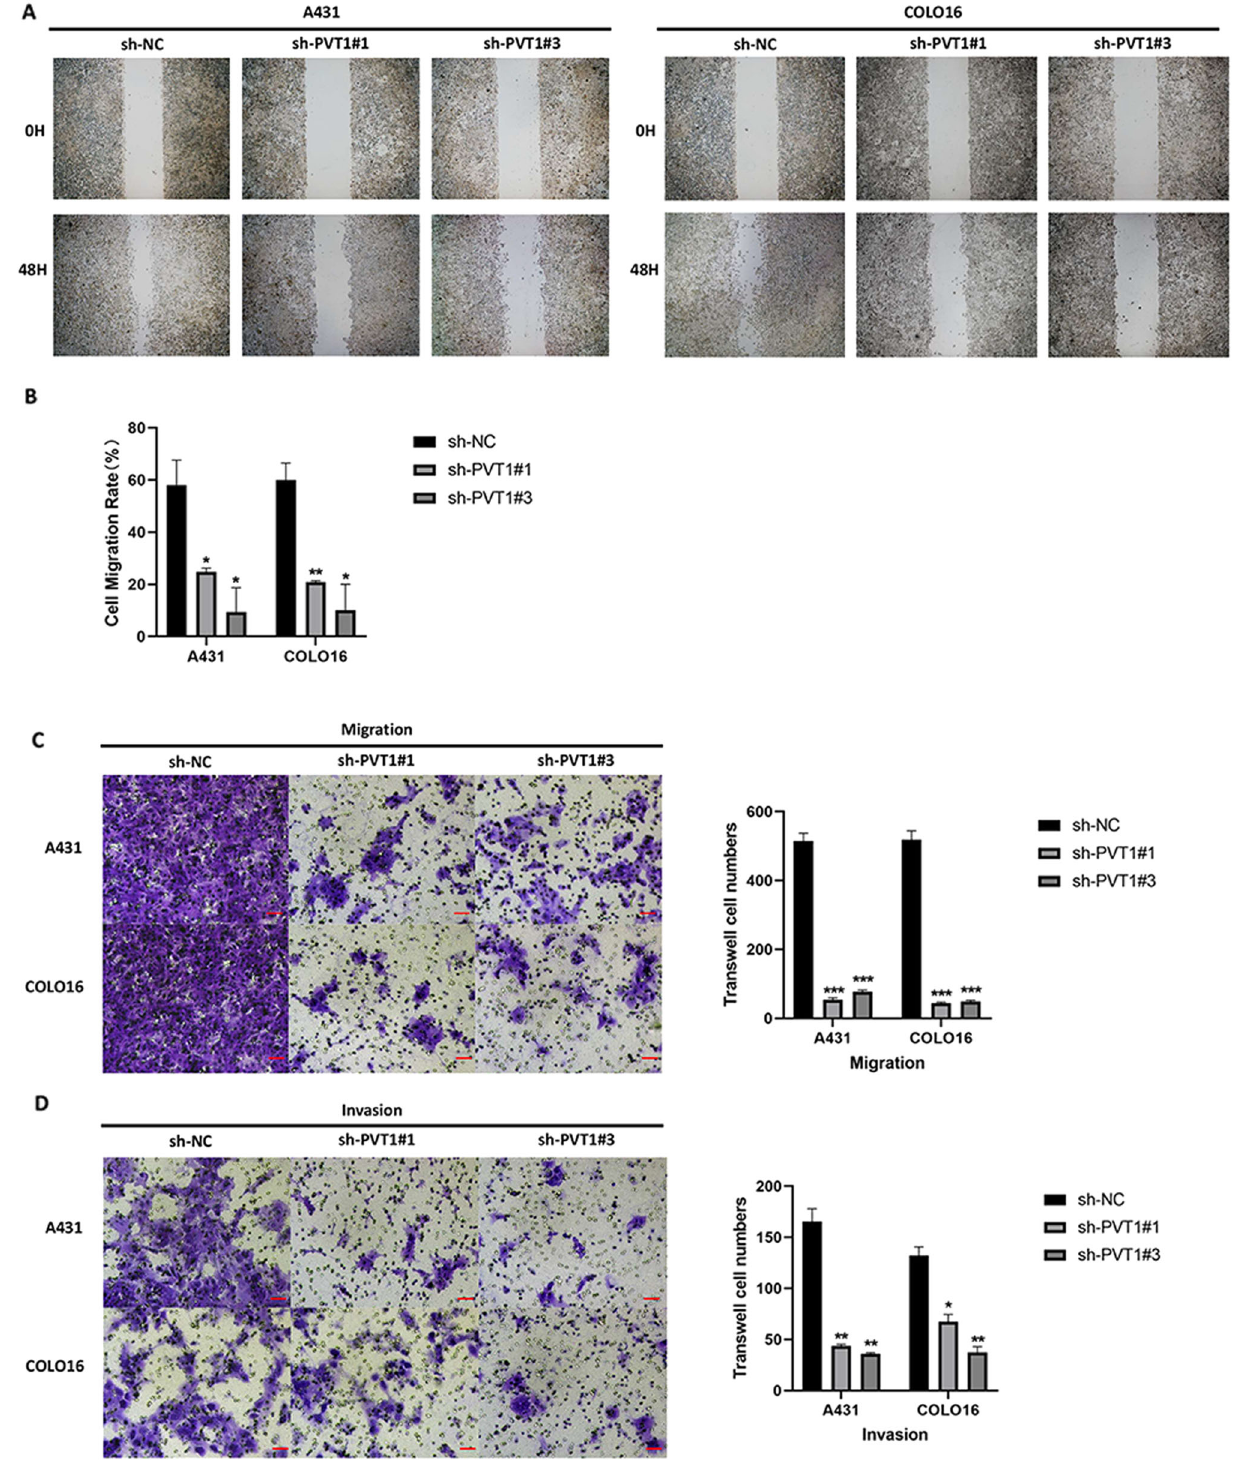
Fig. 3 LncRNA PVT1 knockdown inhibits metastasis and invasion of A431 and COLO16 cells in vitro. A Representative images (×200 magni fi cation, scale bar = 50 µm) and quanti fi cation ( B ) of scratch-wound assays in A431 and COLO16 cells. Images (×200 magni fi cation, scale bar = 50 µm) and quanti fi cation of the number of migrated ( C ) and invaded cells ( D ) by transwell assays in vitro are exhibited. * P < 0.05, ** P < 0.01, *** P < 0.001.